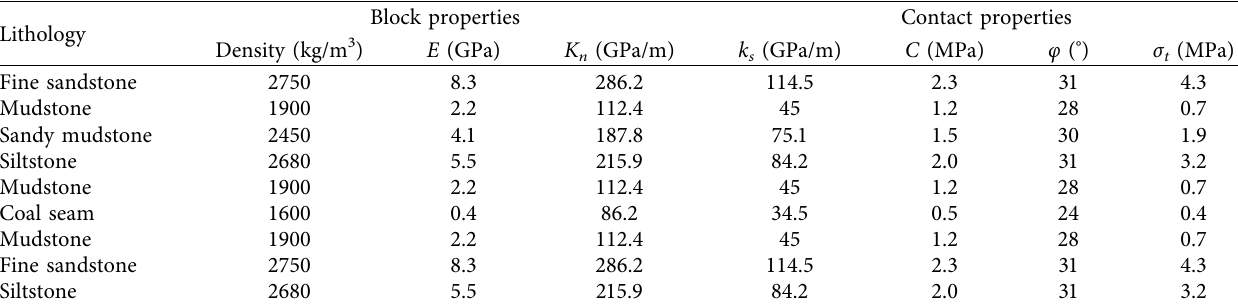
Table 4: The mechanical parameters of the rock mass used in the UDEC